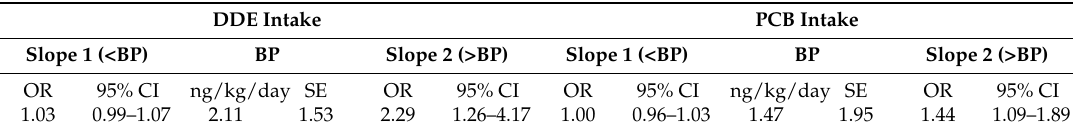
Table 5. Segmented logistic regression of the association between dietary DDE/PCB exposure and T2D in Manitoba and Ontario First Nations *. DDE Intake PCB